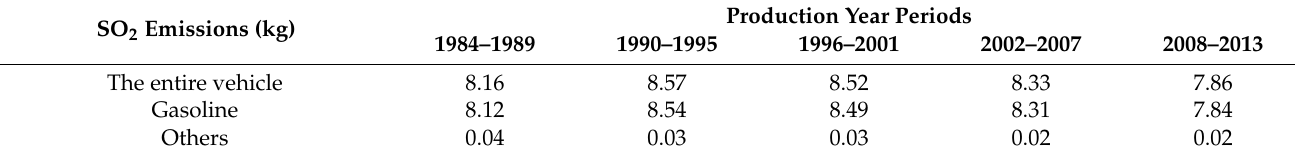
Table 8. Average SO 2 emissions in kg for different production periods.